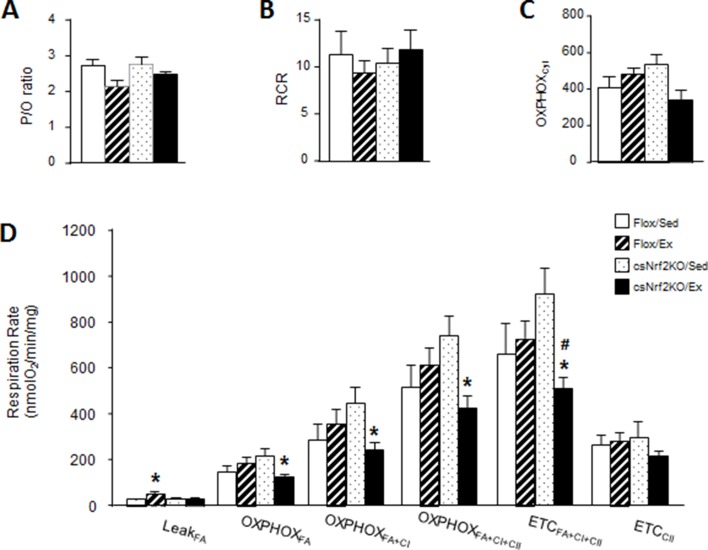
Respiratory rates in isolated cardiac mitochondria of csNrf2KO mice after exercise.(A) The relationship between molecules of ADP phosphorylated and oxygen consumed (P/O ratio). (B) Respiratory coupling ratio (RCR). (C) Cytochrome C was added after oxidative capacity measurement to investigate mitochondrial membrane integrity (OXPHOSCyt). (D) Cardiac mitochondrial function evaluated by a substrate-uncoupler-inhibitor-titration (SUIT) protocol. Mitochondrial proton leak using malate and palmityol carnitine as substrates (LeakFA), maximal oxidative phosphorylation with a saturated amount of ADP (OXPHOXFA), following the addition of complex I substrates, pyruvate and glutamate (OXPHOXFA+CI), and following the addition of complex II substrate, succinate (OXPHOXFA+CI+CII). Maximal electron transport chain (ETC) capacity was measured following the addition of carbonyl cyanide m-chlorophenyl hydrazone (ETCFA+CI+CII), and rotenone was added to measure ETC capacity using complex II substrates (ETCCII). *p<0.05 vs respective sedentary controls, # p<0.05 vs Flox/Ex, 1-way ANOVA followed by Tukey post hoc analysis (n = 4–6/group).